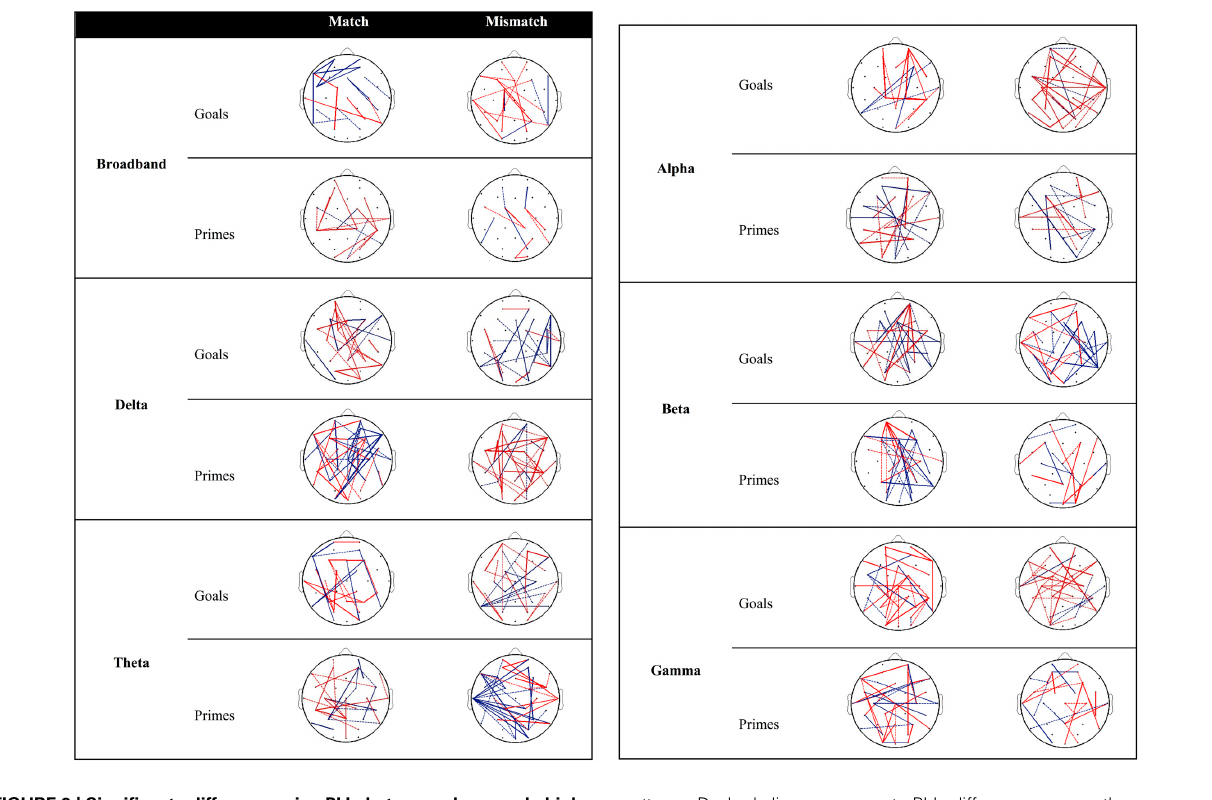
FIGURE 3 | Significant differences in PLI between low and high agency as a function of matching and type of pre-activation across frequency bands. Red lines indicate that PLI low agency > PLI high agency, whereas blue lines represents the opposite